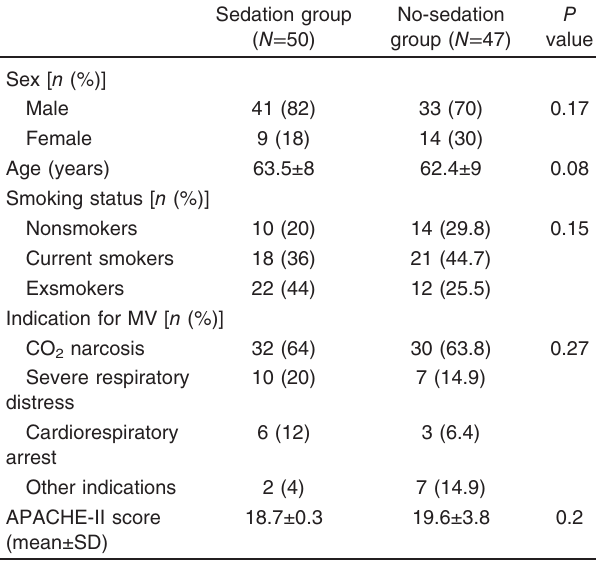
Table 1 Demographic data and patient characteristics